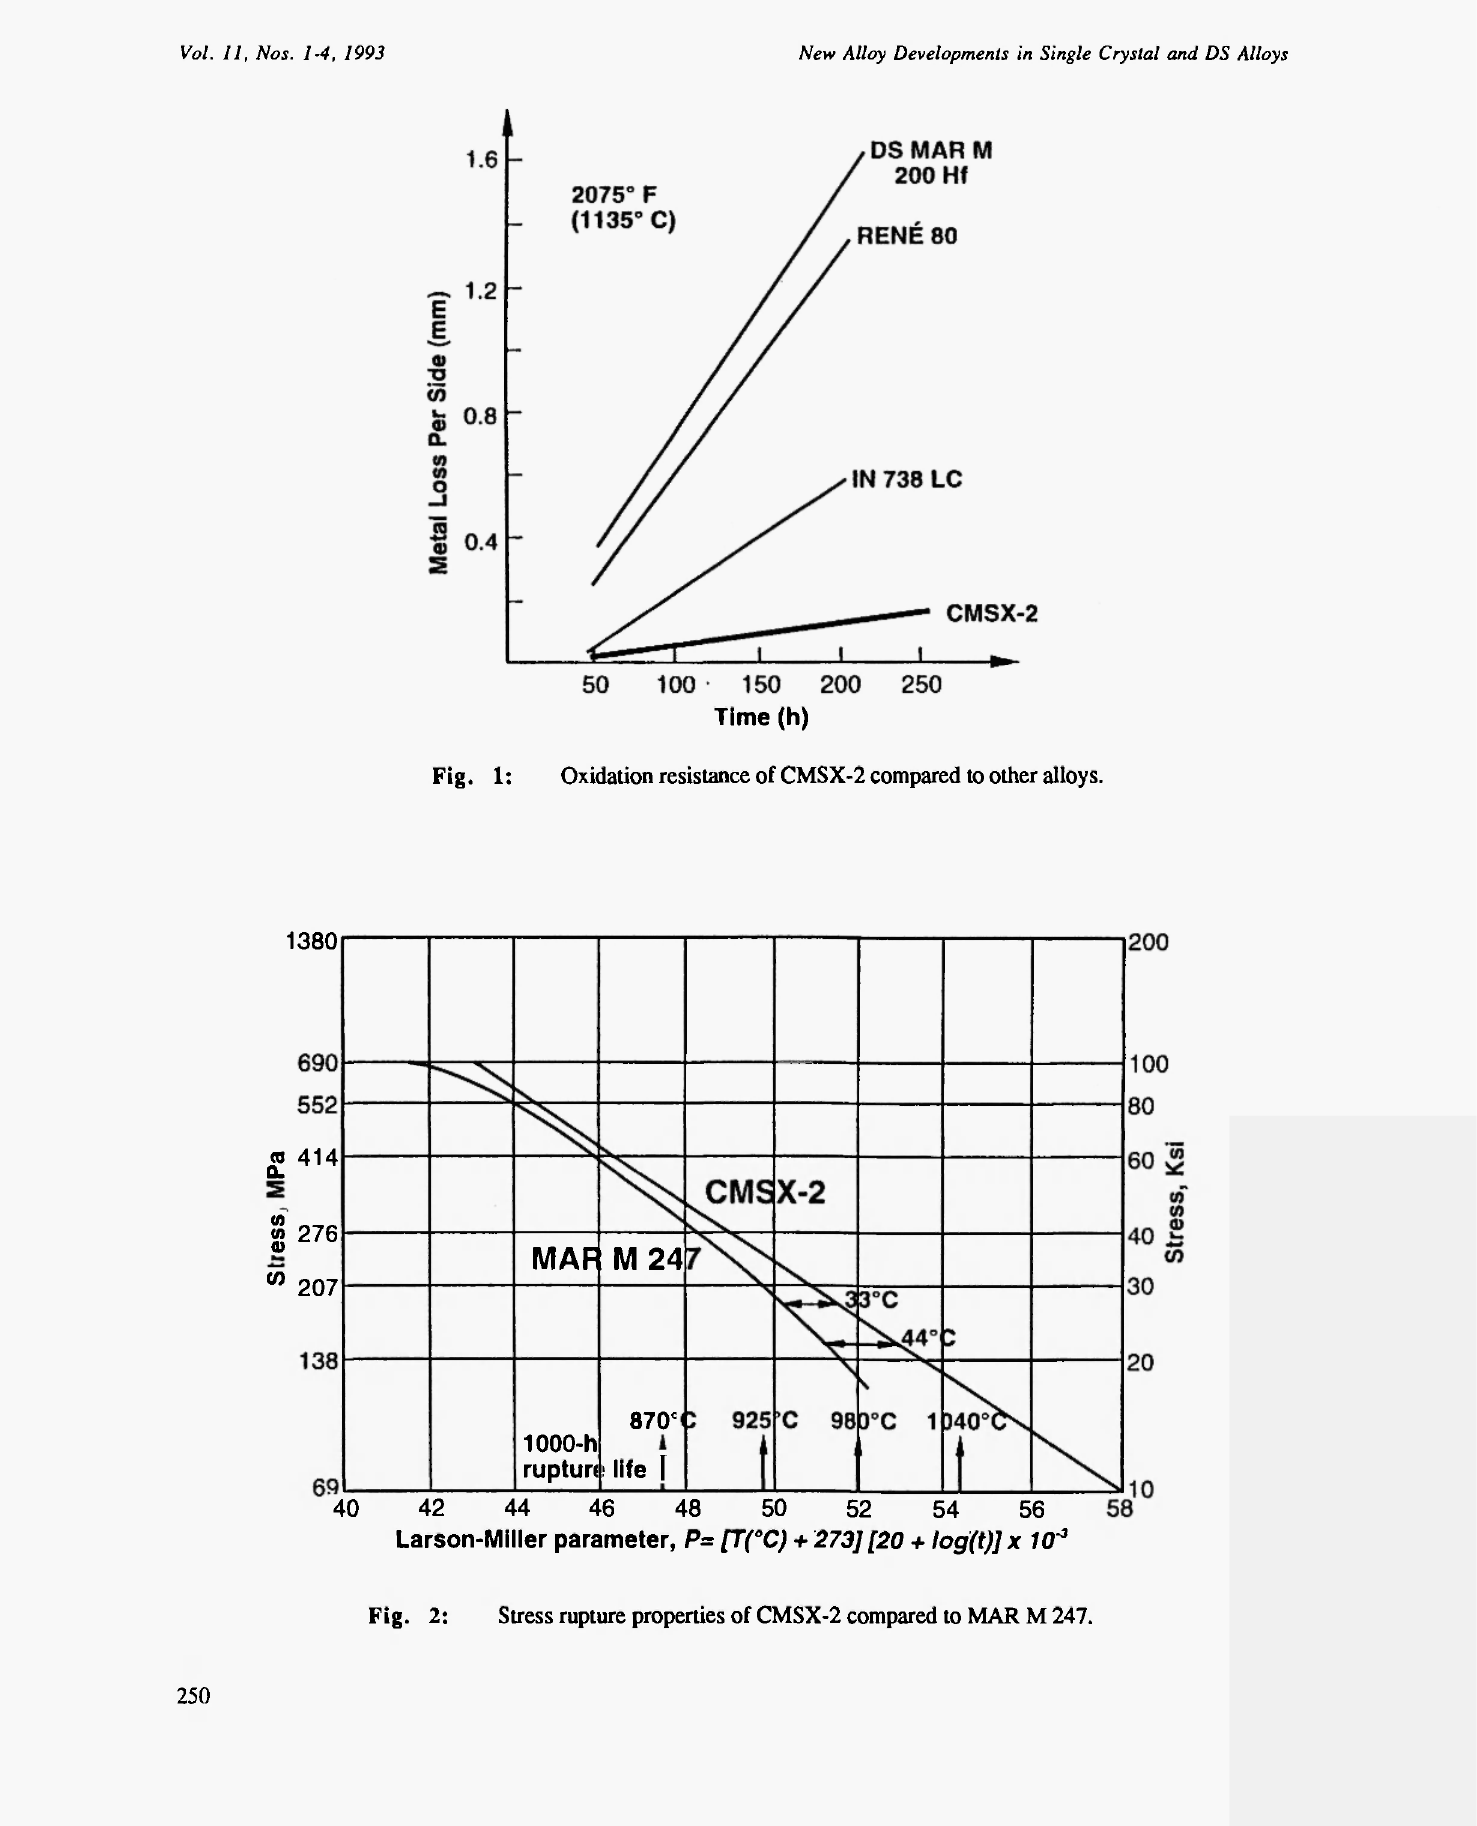
Fig. 1: Oxidation resistance of CMSX-2 compared to other alloys.